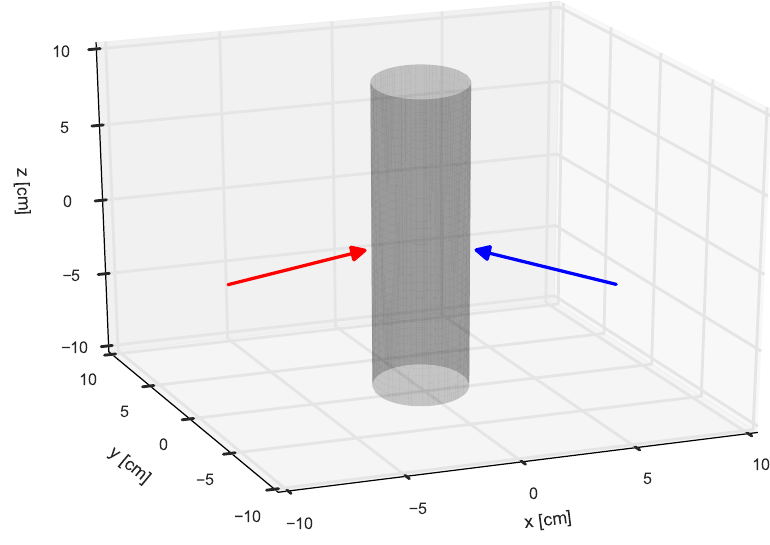
Figure 6. Experiment 1: lifting a cylindrical (radius = 3 cm) mass load (0.44 kg); the force vectors for thumb (red) and index finger (blue) are displayed when the load was grasped and held still in the air. Both vectors are expressed in the global reference frame.